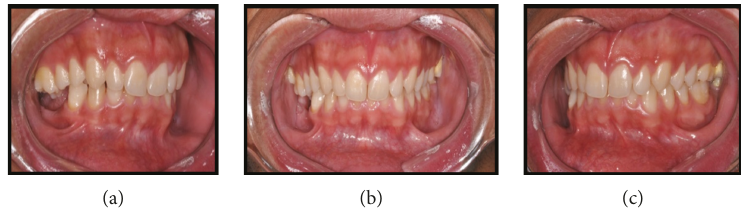
Figure 2: (a), (b), and (c) Preoperative intraoral pictures emphasizing deep bite and teeth absence on the right side.